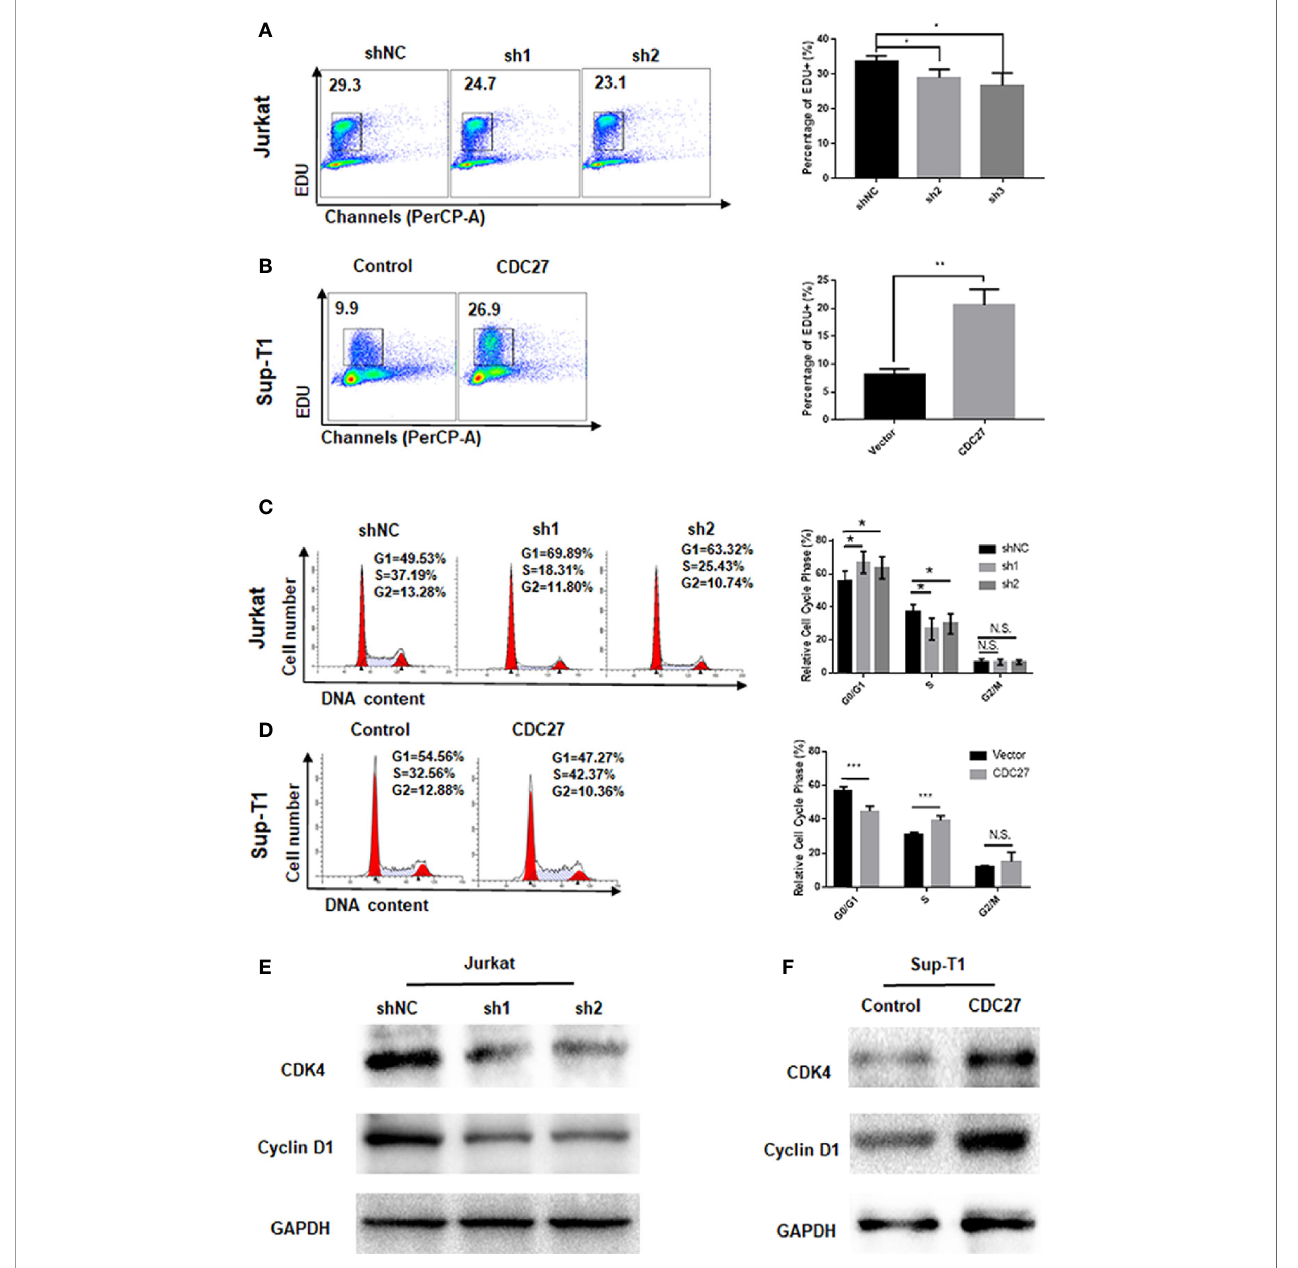
FIGURE 3 | CDC27 in fl uence the G1/S phase transition. (A, B) Cell proliferation were assessed by EdU incorporation assay. Data are representative of at least three independent experiments. ** P < 0.01, * P < 0.05. (C, D) Flow cytometry was used to examine the cell cycle by PI staining of both Jurkat and Sup-T1 cells. Images and quali fi cation of the cell cycle distribution in three independent experiments are shown. * P < 0.05, *** P < 0.001. N.S., not signi fi cant. (E, F) Western blot was performed to detect the expression levels of cell cycle related proteins in both Jurkat and Sup-T1 cells,